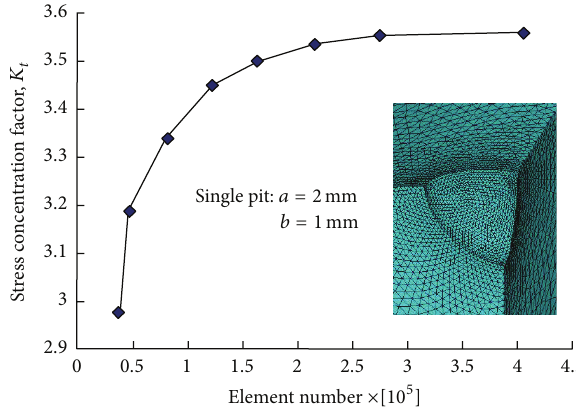
Figure 4: Variations of stress concentration factor with element number.